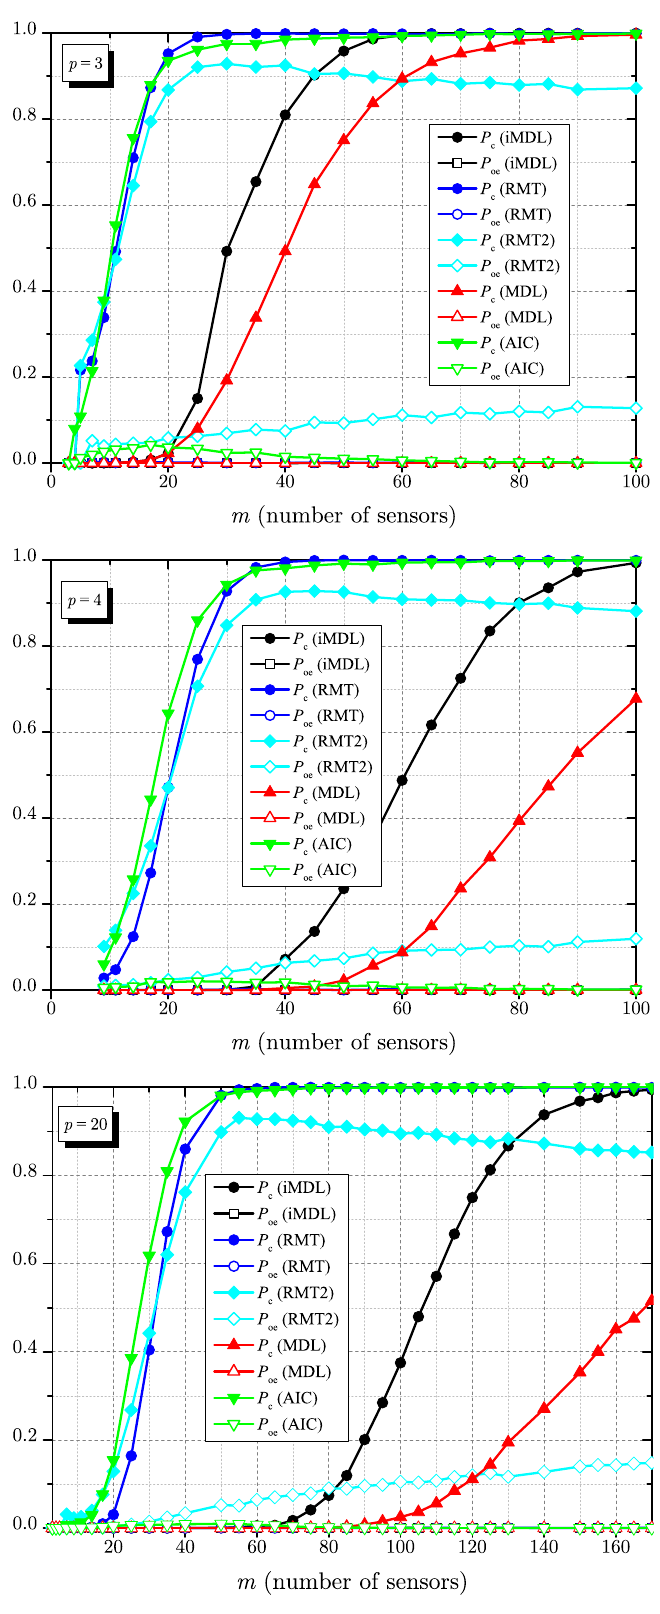
Figure 6. P and P against m for SNR = − 10 dB, n = 1000 , p = 3 ( top ); p = 4 ( middle ) c oe and p = 10 ( bottom